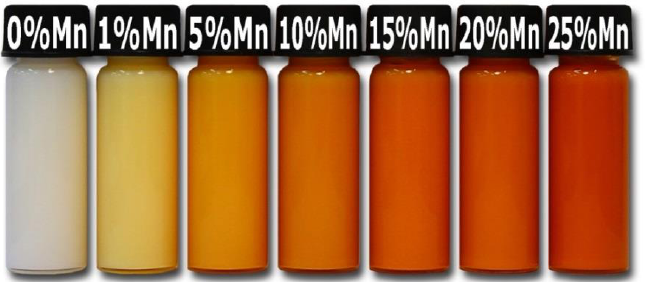
Figure 42. ( a ) SEM image of ZnO tubes (Reprinted from [868], Copyright (2005), with permission from